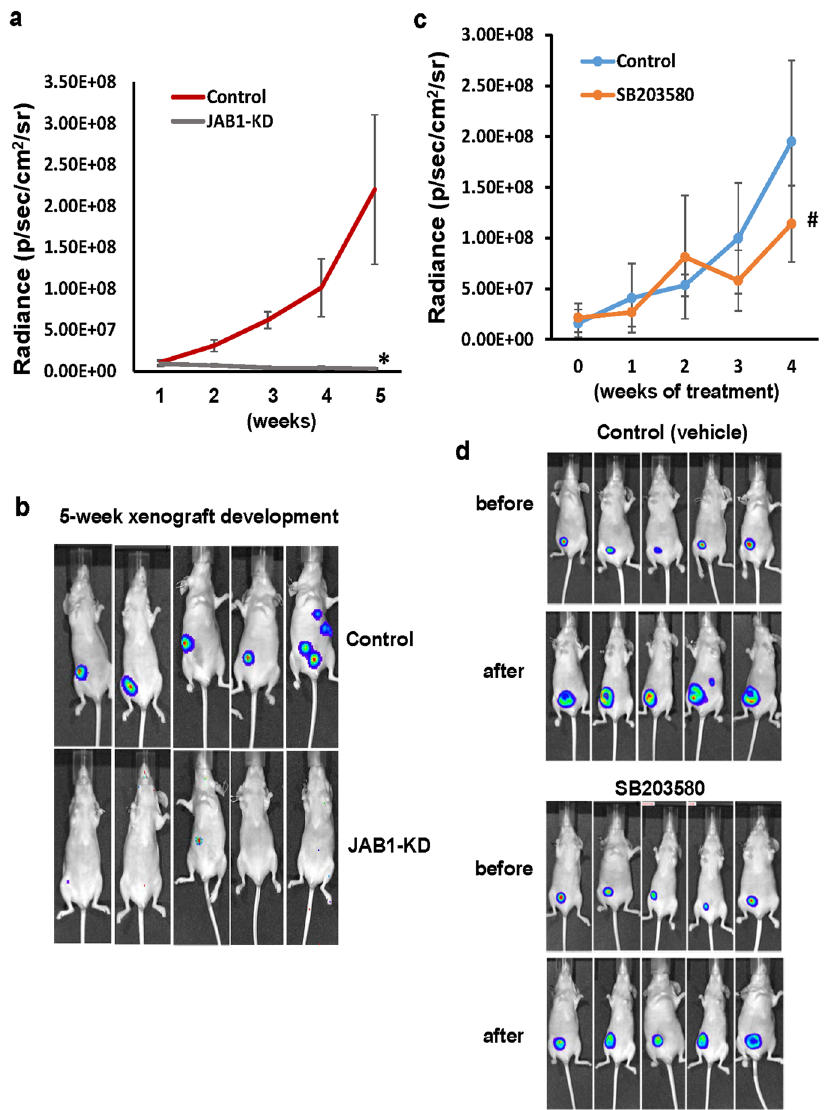
monitored weekly using the Xenogen IVIS-200 In Vivo bioluminescence imaging system. Data are means ± SD. n = 5. Statistical analysis was performed using Student t test (two-tailed) for the end experiment point. * P < 0.001. b Images of the xenograft tumors at 5 week. The image data is displayed in radiance or photons/sec/cm 2 /steradian. c Luciferase-expressing MDA-MB-231 cells were injected into nude mice for 5 days. Mice were randomized and treated daily with either Vehicle control or 1 µmol/kg of SB203580 i.p. for 4 weeks. Tumor growth